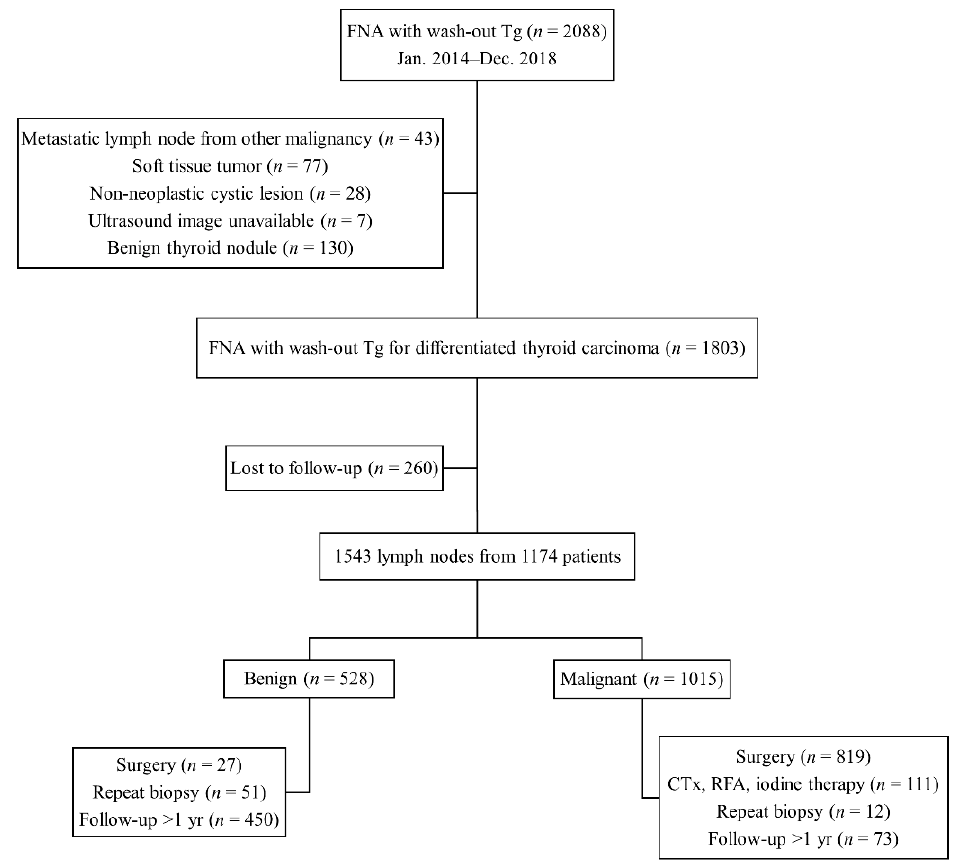
Figure 4. Flowchart showing the study population.